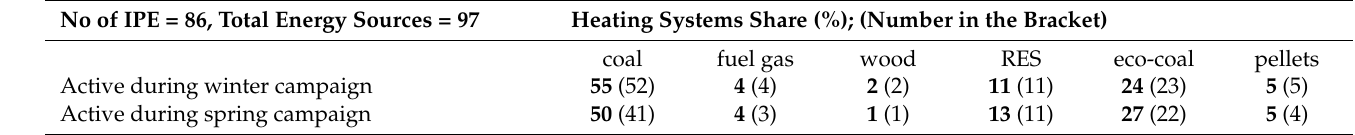
Table 1. Characteristics of Individual Point Emitters (IPE) related to the individual hot water supply and energy for